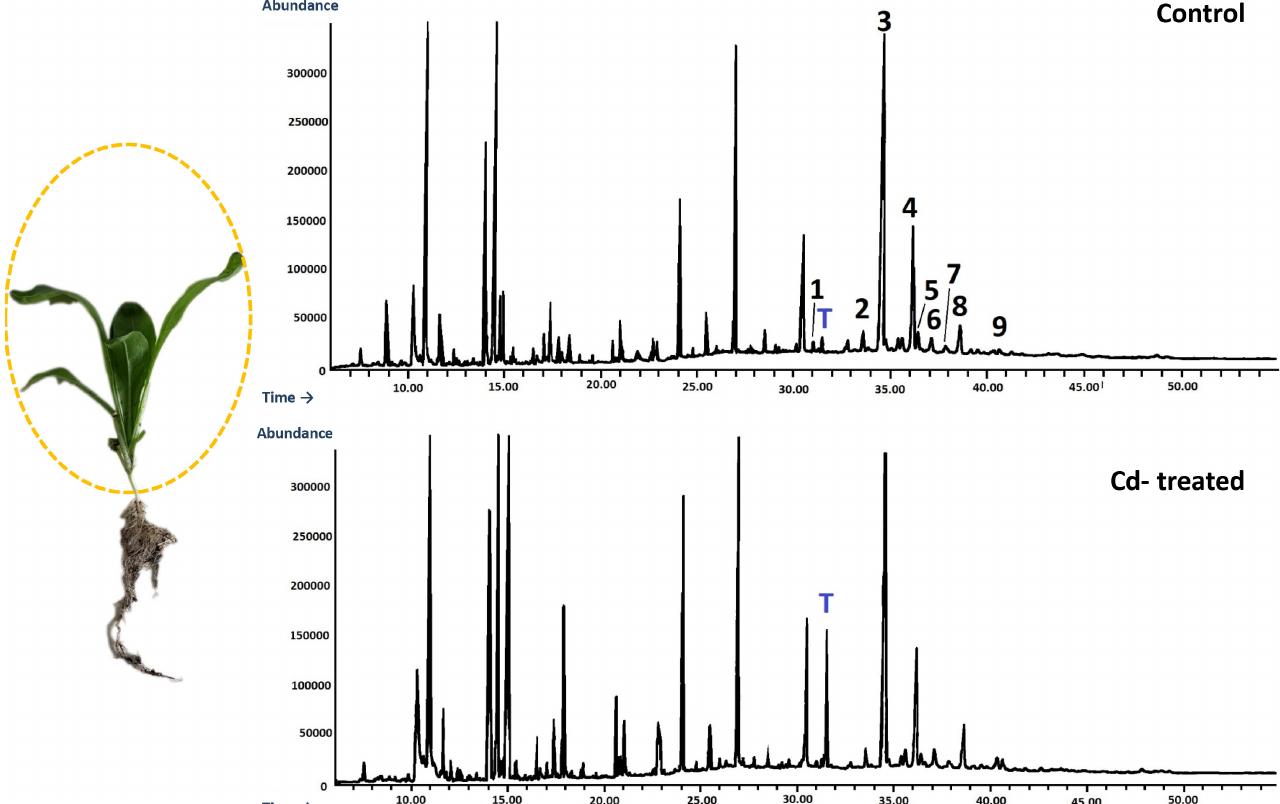
Figure 19. Representative chromatograms of the fractions containing free steroids from diethyl ether extracts obtained from control and cadmium-treated shoots of marigold plants after 14 days of cultivation: 1, cholesterol; 2, campesterol; 3, stigmasterol; 4, sitosterol; 5, sitostanol; 6, β -amyrin; 7, α -amyrin; 8, tremulone; 9, sitostenone. T— α -tocopherol.